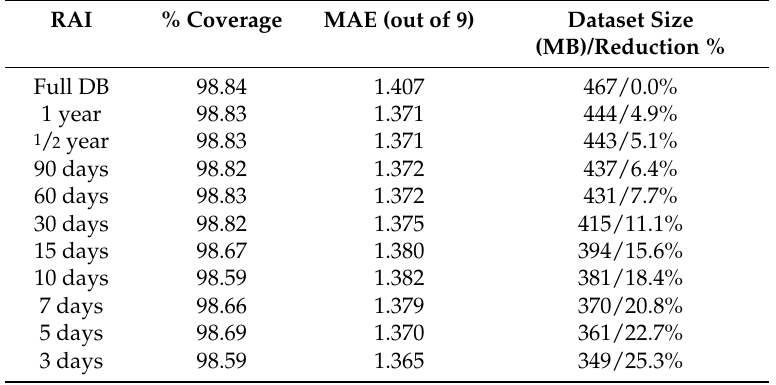
Table 6. MovieLens “latest 20 M—recommended for new research” dataset results.